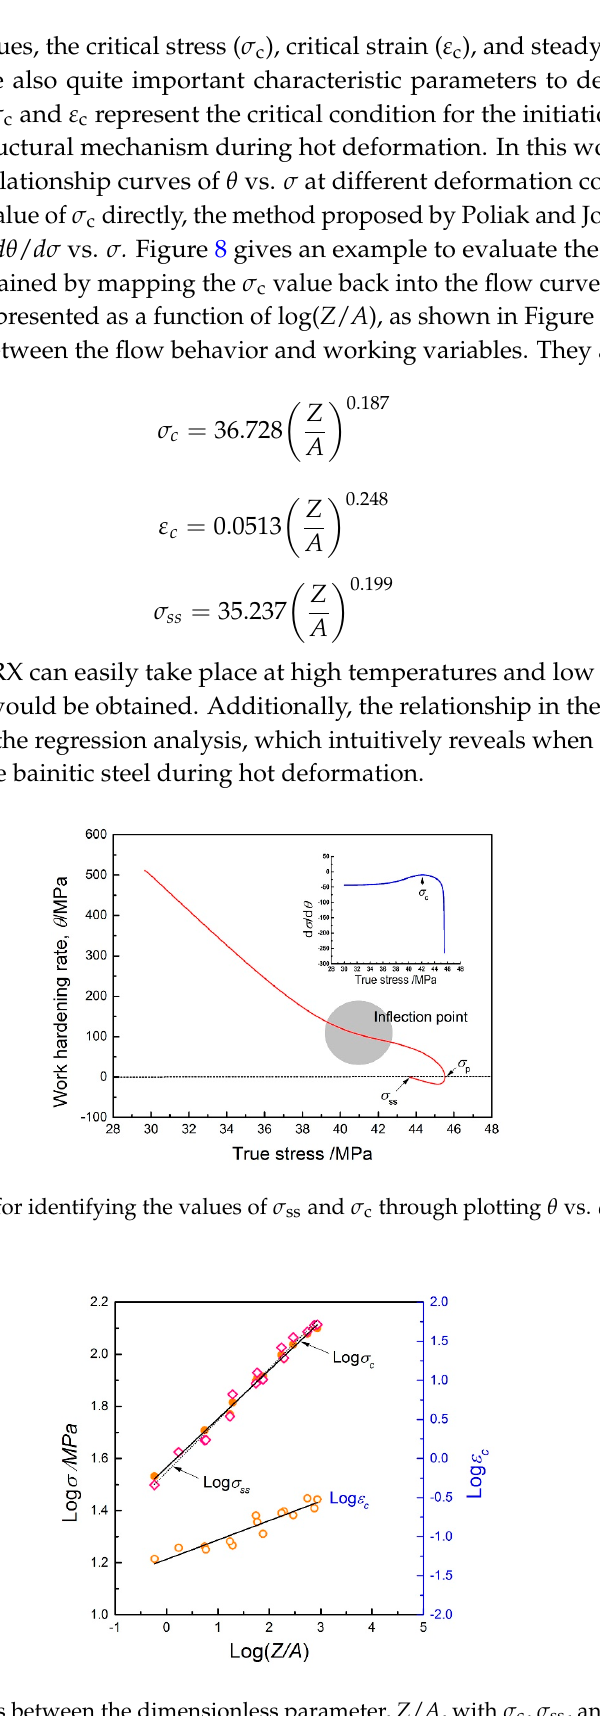
Figure 9. Relationships between the dimensionless parameter, Z / A , with σ c , σ ss , and ε c , respectively.